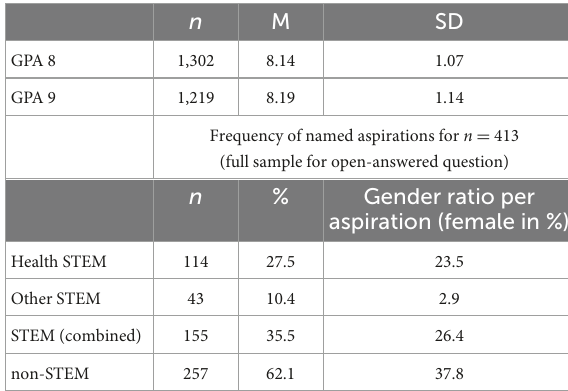
TABLE 2 Descriptive data of achievement and occupational